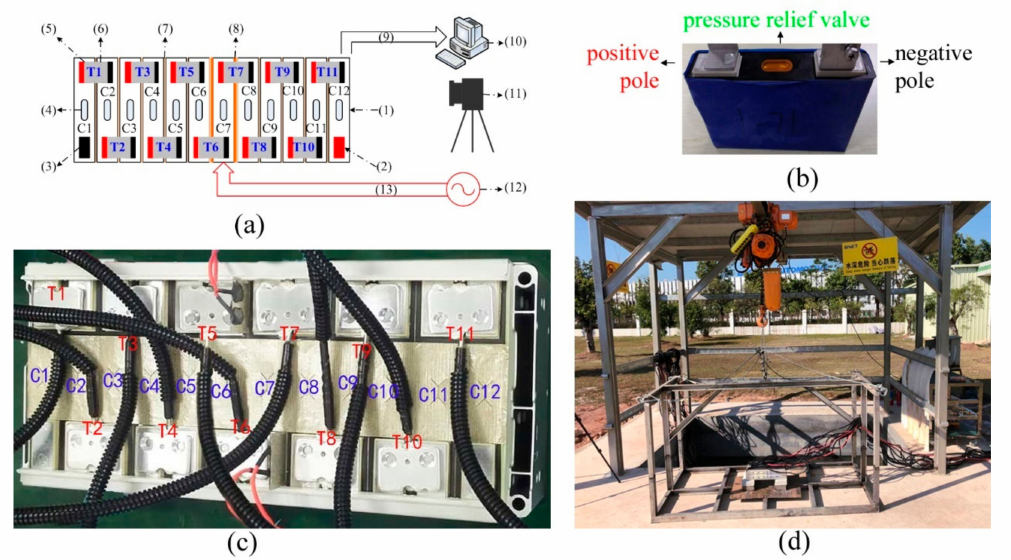
Figure 1. Experimental setup: ( a ) schematic, (1) cell, (2) positive pole, (3) negative pole, (4) pressure relief valve, (5) aluminum bar, (6) thermocouple, (7) heat insulation interlayer, (8) heater, (9) signal harness, (10) data logger, (11) video camera, (12) AC power supply, (13) power harness, ( b ) cell sample, ( c ) battery module, and ( d ) test